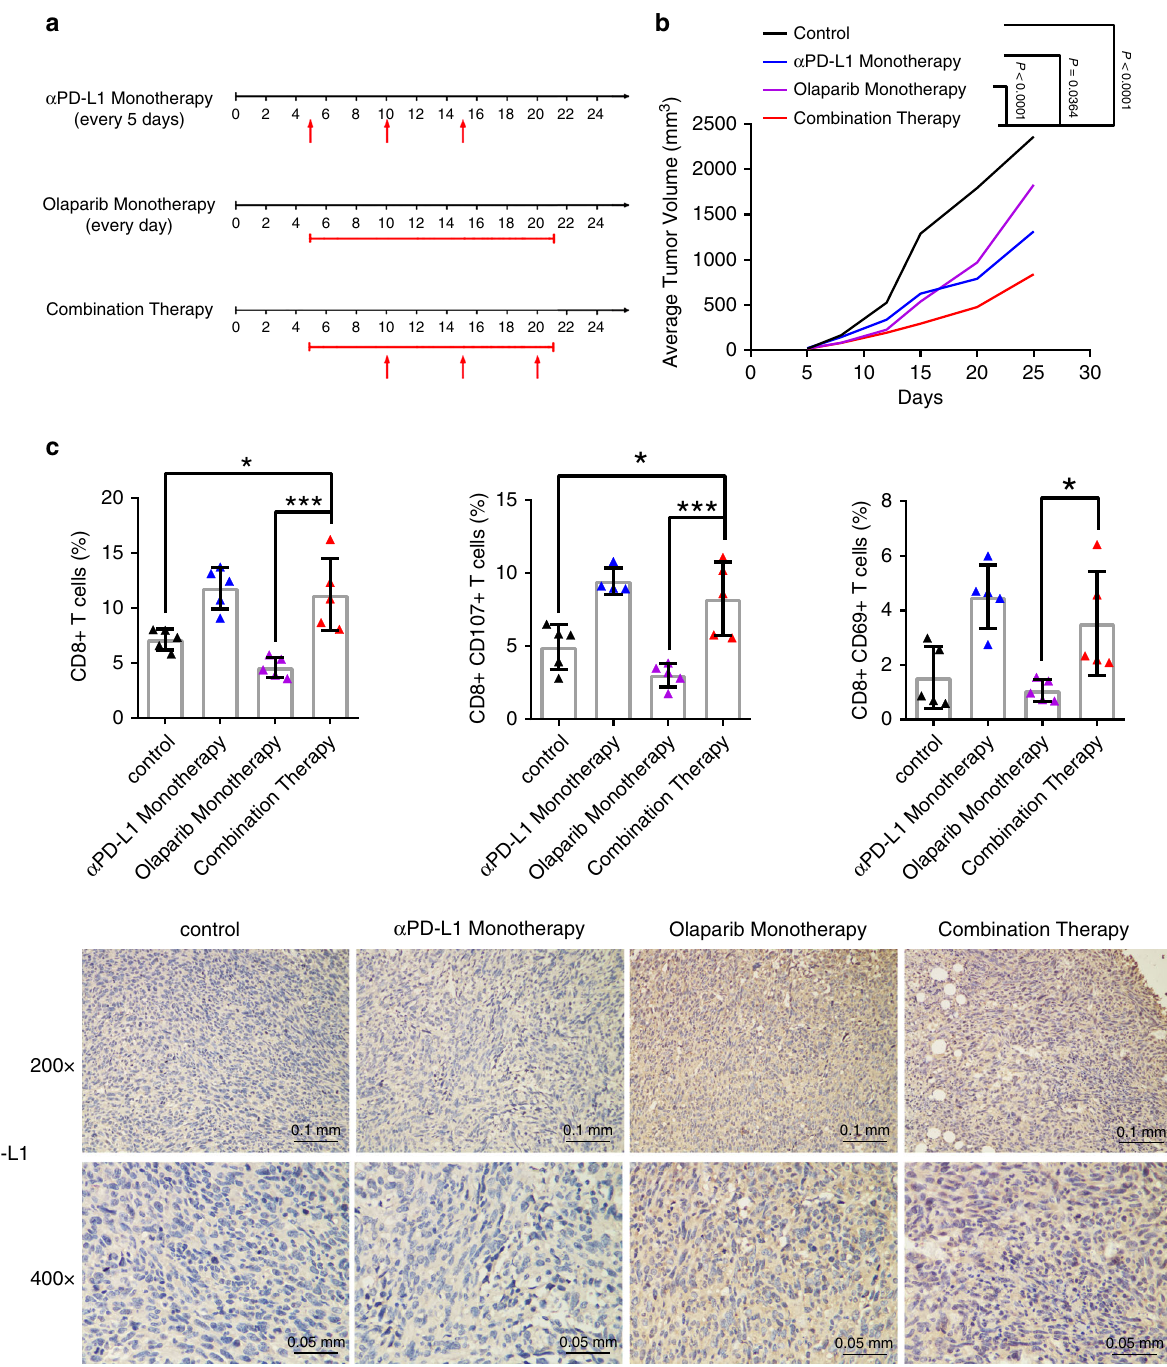
Fig. 7 Olaparib and anti-PD-L1 combination therapy was superior to monotherapy in vivo. a Schematic diagram of dosage regimen. Control group was treated with PBS and IgG. α PD-L1 monotherapy group was treated with PBS and α PD-L1 200 μ g per mouse. Olaparib monotherapy group was treated with IgG and olaparib 50 mg kg − 1 . Combination therapy group was treated with α PD-L1 200 μ g/mouse and olaparib 50 mg kg − 1 . b 0.5 × 10 6 4T1-sh-BRCA1 cells were injected into the mammary fat pads of BALB/c mice. The average tumor volume of each group was recorded over time. c TILs in the tumors of each group ( n = 5) were analyzed by fl ow cytometry. d PD-L1 expression was detected by IHC in mouse tumor tissues of each group. Data were presented as mean ± s.d. of three independent experiments. b , c were analyzed by one-way ANOVA + two-side Tukey test. * P < 0.05, *** P < 0.001. Source data are provided as a Source Data fi